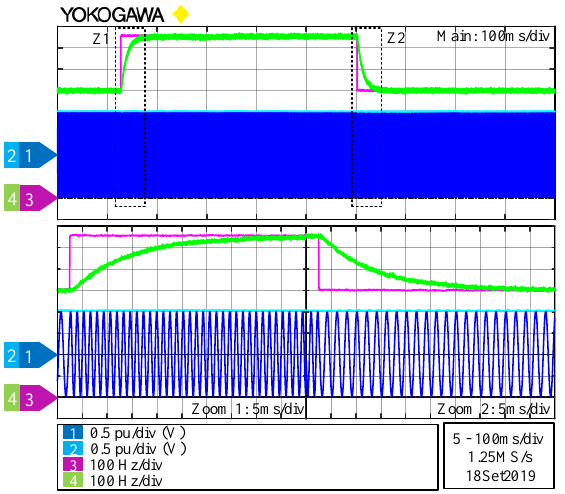
Figure 24. Experimental results related do Test 3—frequency steps 500-750-500 Hz.